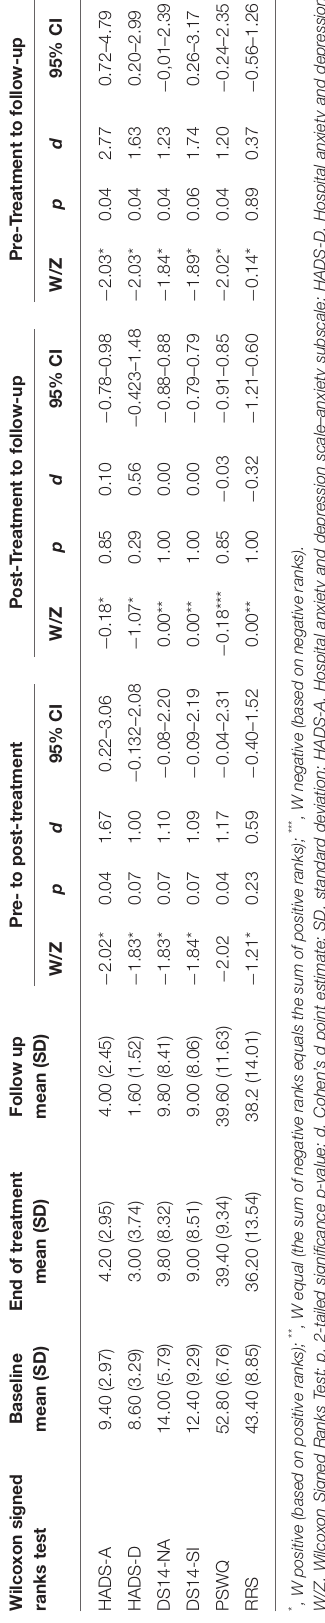
TABLE 3 | Psychiatric disorders, personality disorders, type D personality, and insomnia.